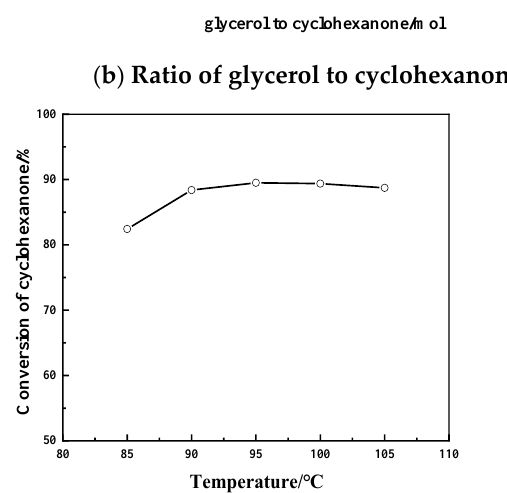
Catalyst loading/g